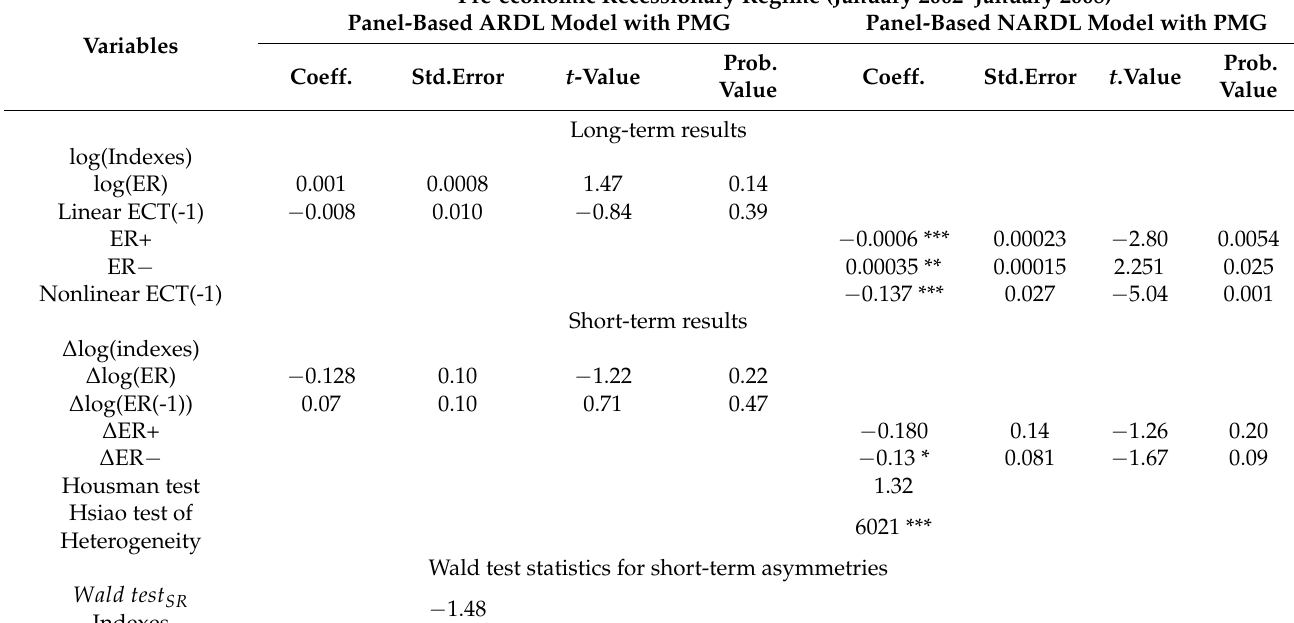
Table 6. Heterogeneous linear and nonlinear panel ARDL modeling approach with